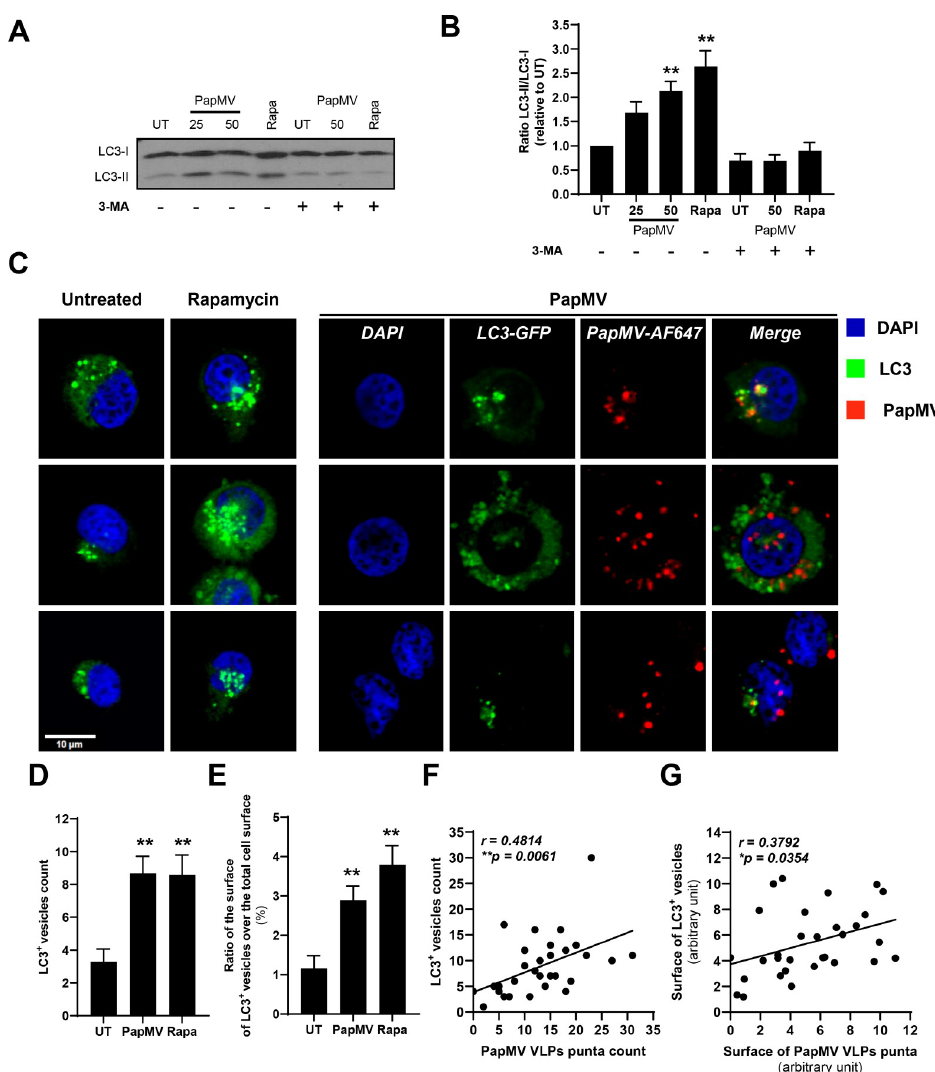
Fig 3. Autophagy is induced in APC following incubation with PapMV VLPs. (A, B) EBV-B cells were treated for 3 hours with PapMV VLPs (indicated concentration in μ g/mL) or rapamycine (Rapa, 0.1 μ M) with or without 1-hour pretreatment with 3-MA (5 mM). Cells were collected, protein extracted and resolved by SDS-PAGE using a 15% acrylamide gel, and LC3 was revealed by western blot. The scanned image of the blot was cropped between 20 kDa and 10 kDa for LC3 and is representative of three independent experiments. Full-length blot is presented in S5 Fig. (B) Ratio of densitometry of LC3-II/LC3-I bands relative to the untreated (UT) control. Data are pooled from seven (without 3-MA treatment) or three (with 3-MA treatment) independent experiments and are represented as mean ± SEM. Statistical significance was calculated using a one-way ANOVA with post-hoc Dunnett’s multiple comparison test. Statistical significance was defined at p < 0.05. �� p < 0.01 significantly lower than UT control. (C-E) EBV-B cells were transfected with LC3-GFP plasmid and GFP + cells were sorted and incubated for 3 hours with PapMV-AF647. C Pictures of representative cells per condition (untreated, PapMV or rapamycin) at 60x magnification from one representative experiment of three independent experiments. Blue: DAPI, Green: LC3-GFP and Red: PapMV-AF647. Scale bar represents 10 μ m. (D, E) Quantification of LC3 + vesicles per cell (D) and the relative surface of LC3 + vesicles over total cell surface ( E ). Data are from a compilation of 24 (untreated), 32 (PapMV) and 31 (Rapamycin) cells from one representative experiment of three independent experiments and are shown as mean ± SEM. Statistical significance (defined at p < 0.05) was calculated using a one-way ANOVA with post-hoc Tukey HSD. �� p < 0.01 significantly lower than untreated (UT) control. (F, G) Linear regression plots showing the correlation between (F) the number of LC3 + vesicles and the number of PapMV VLP puncta or (G) the surface of LC3 + vesicles and the surface of PapMV VLP puncta. Pearson correlation coefficients were calculated with 30 cells from one representative experiment of three independent experiments. � p < 0.05 �� p < 0.01.